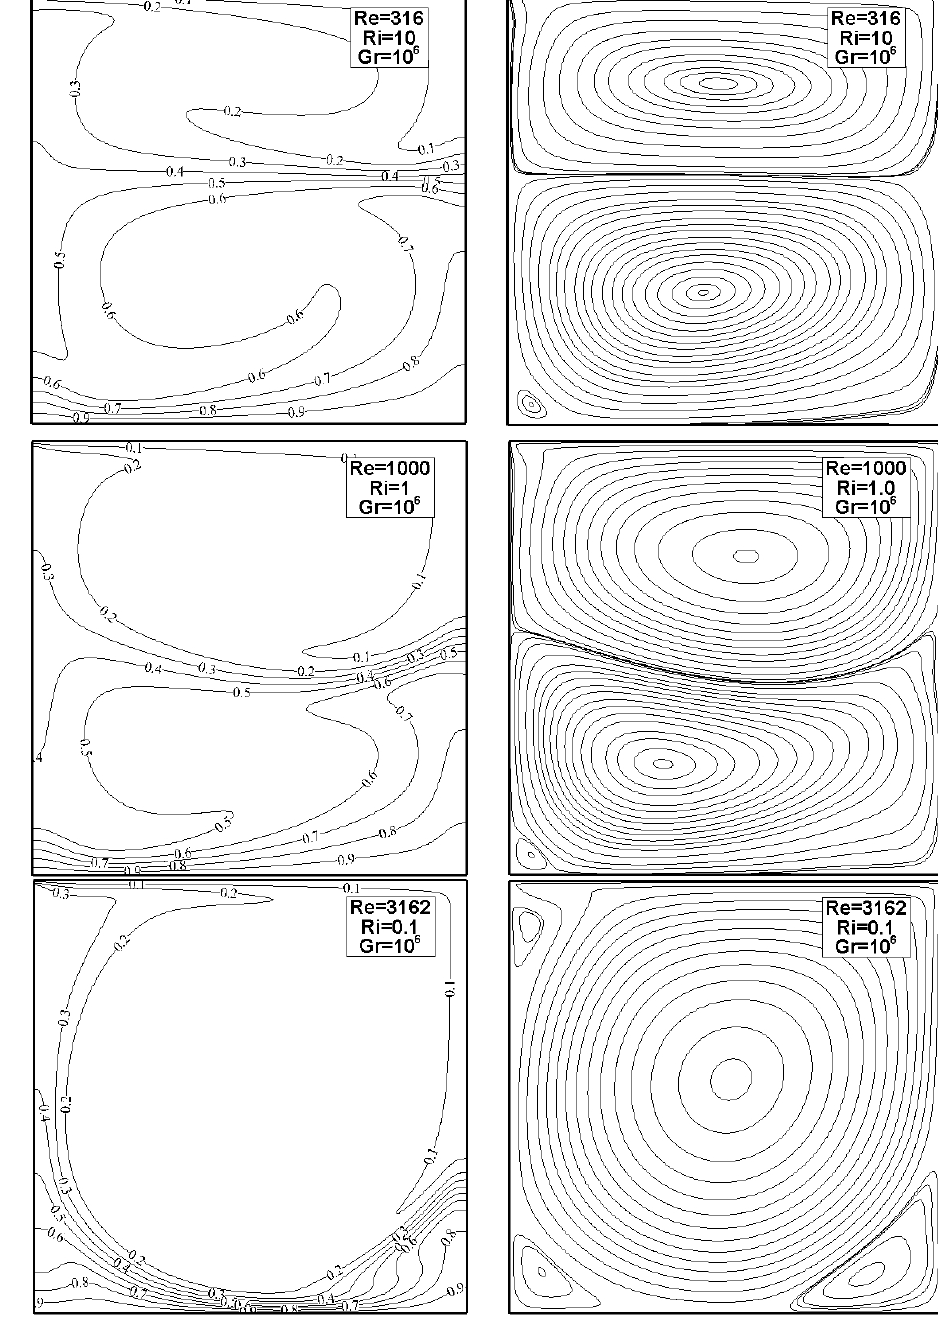
(74) Figure 4. Physical configuration of mixed convection in a lid ‐ driven cavity. Referring to set ‐ ups in previous studies [26,27], here we set Gr = 10 6 and Pr = 0.71, and three cases with different Richardson numbers of 10, 1.0 and 0.1 are simulated. Uniform mesh with the size of 251 × 251 is adopted in our simulations. Figure 5 presents isotherms and streamlines at steady state obtained by USTLBM. As can be seen, smoothness of the isotherms and streamlines is well maintained by the present USTLBM. It is also